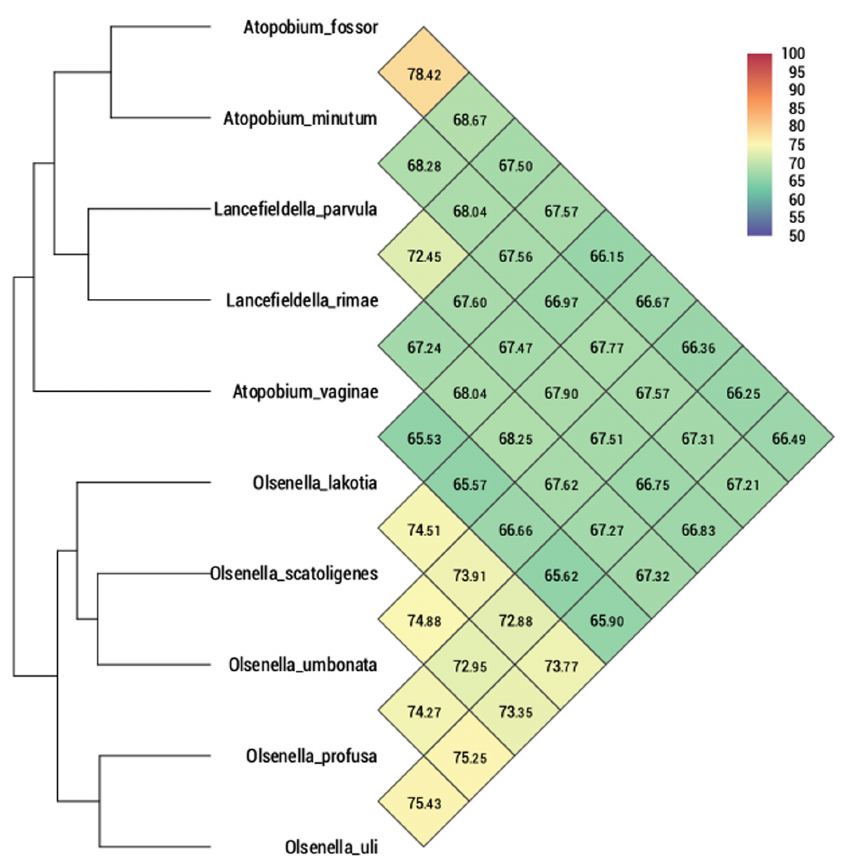
Figure 4. Average nucleotide Identity comparison of O. lakotia SW165 T and closely related strains. Heatmap represents OrthoANI values generated using OAT software between O. lakotia and related taxa with valid taxonomy.